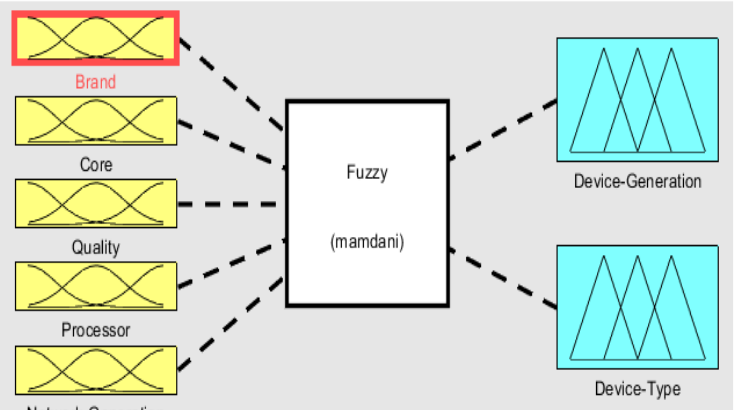
Figure 2. Proposed HKCFIS